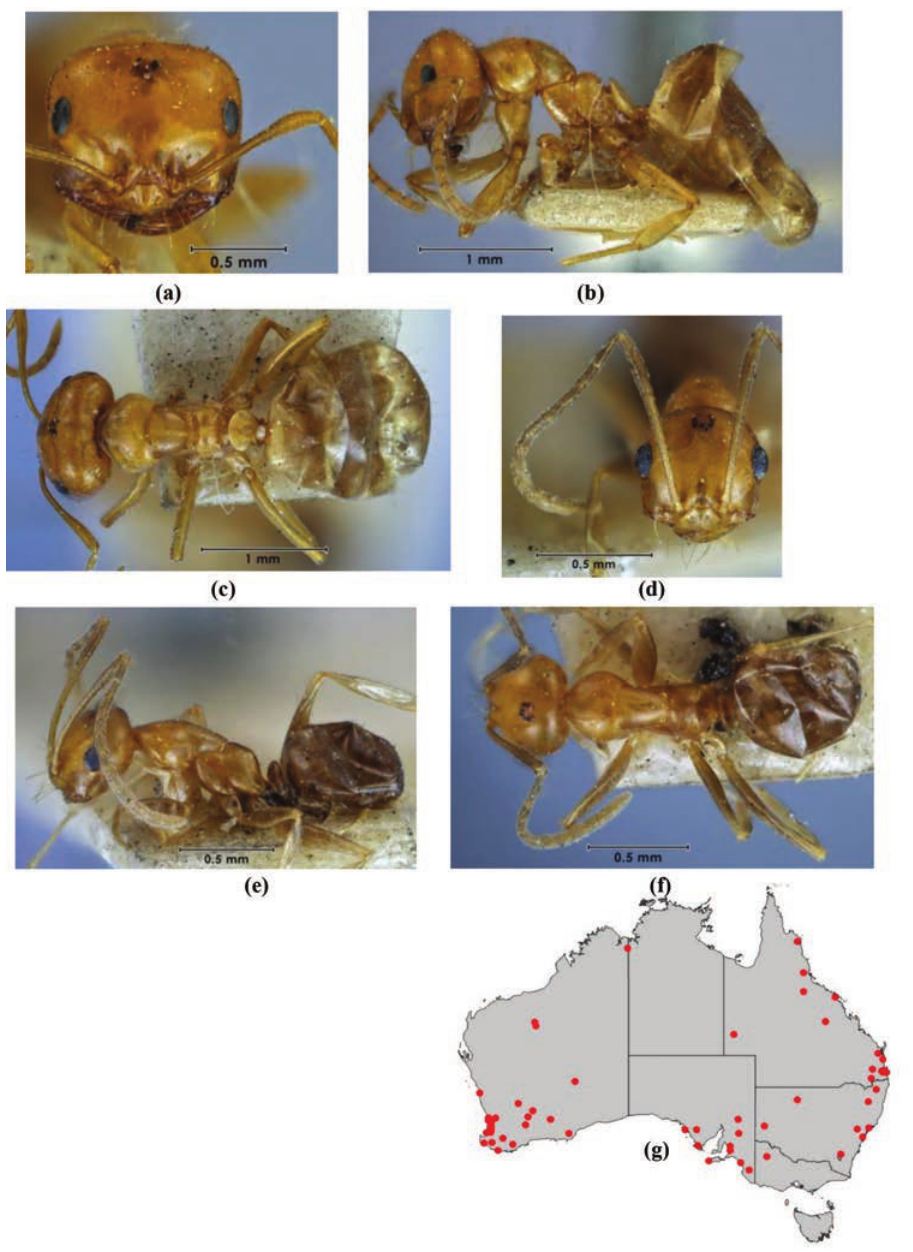
Figure 92. Melophorus ludius Forel: MHNG major worker syntype frons ( a ), profile ( b ) and dorsum ( c ); MHNG minor worker syntype (on same pin as major worker) frons ( d ), profile ( e ) and dorsum ( f ); distribution map for the species ( g